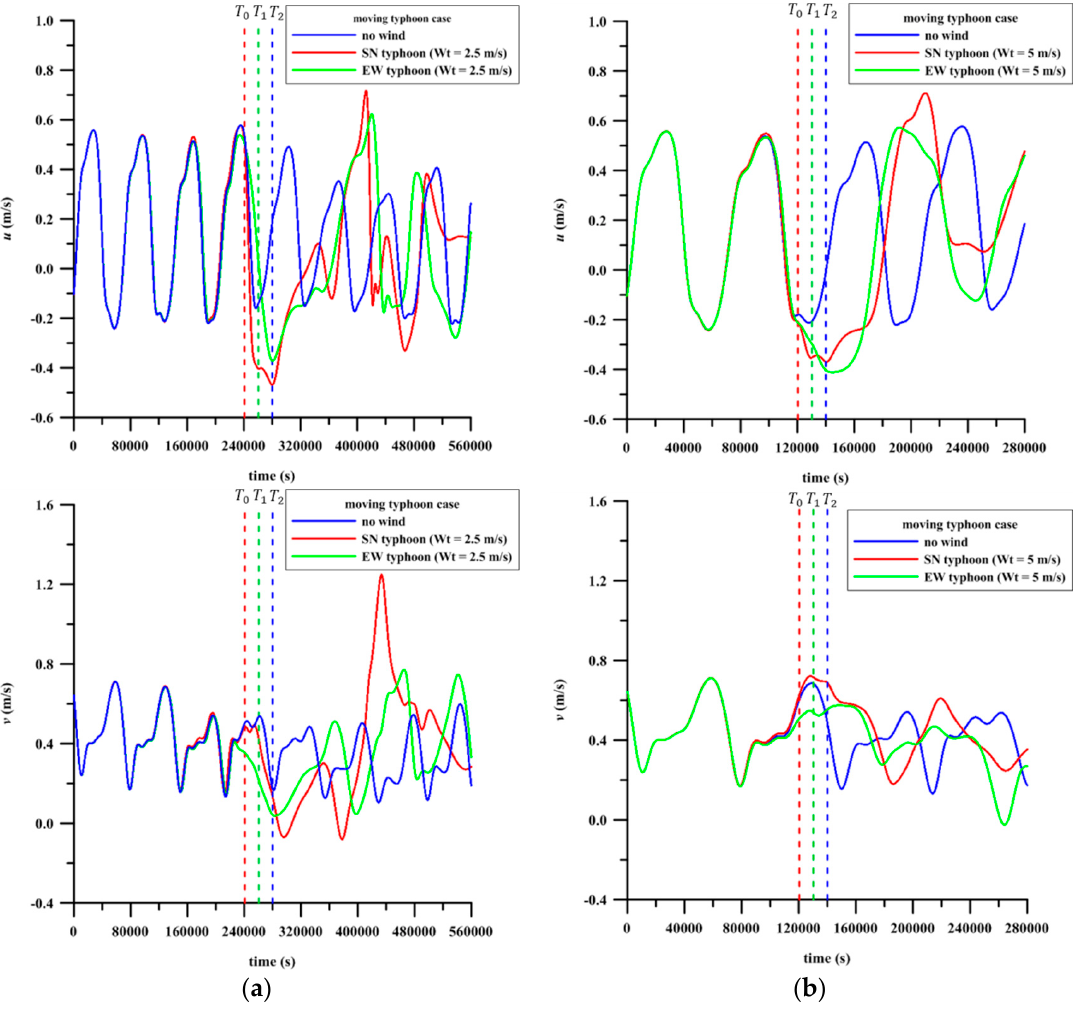
Figure 16. Comparison of u and v of monitor point P of no wind, SN , and EW typhoon with the moving speed W T = ( a ) 2.5 m/s (upper row) and ( b ) 5.0 m/s (lower row), respectively.